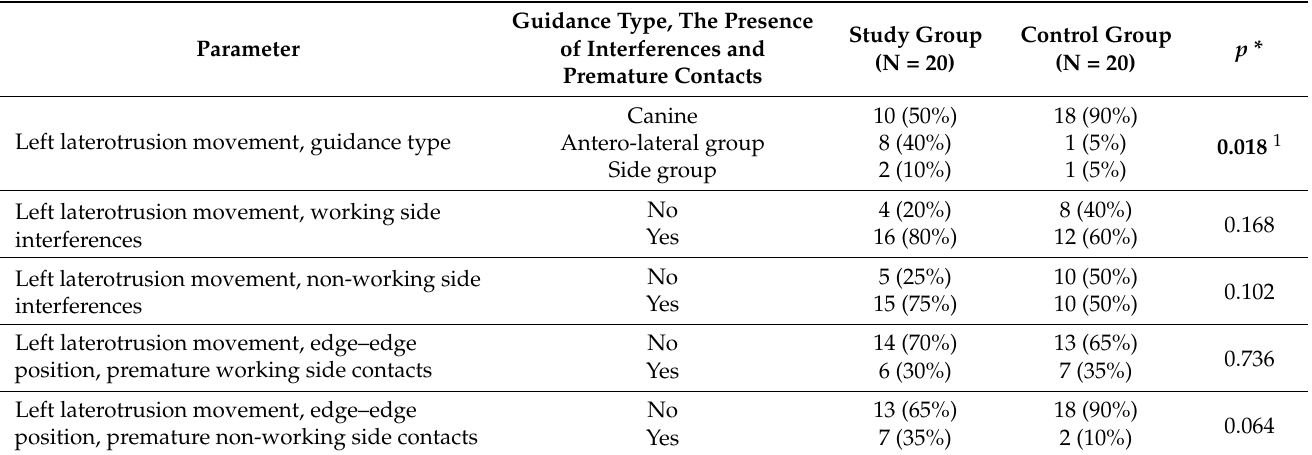
Table 10. Evaluation of the left laterotrusion movement according to the type of guidance, the presence of working and non-working interferences, and premature